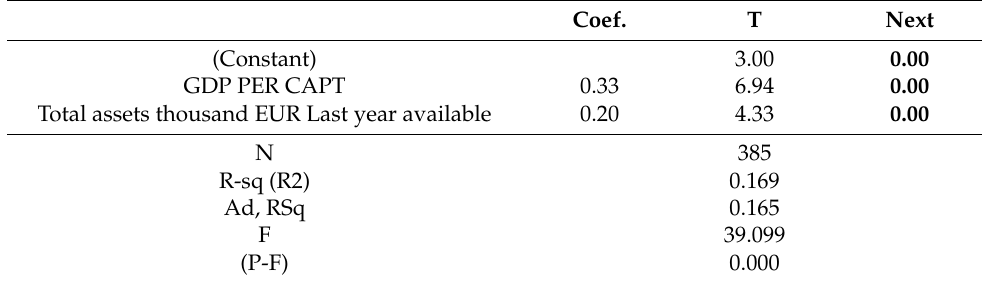
Table 9. Model A coefficients Source: own development.